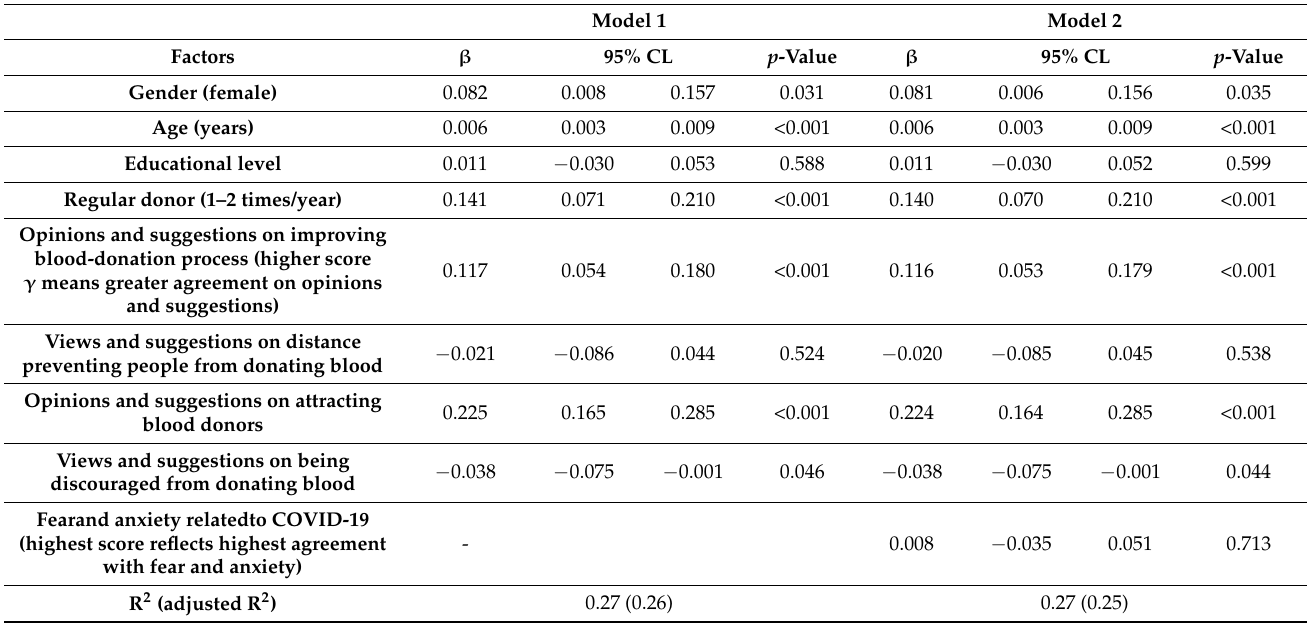
Table 3. Hierarchical models of multiple linear regression of attitude-and-behavior scale in terms of characteristics of participating blood donors, their information and data on blood donation, opinions and suggestions, and fear and anxiety related to